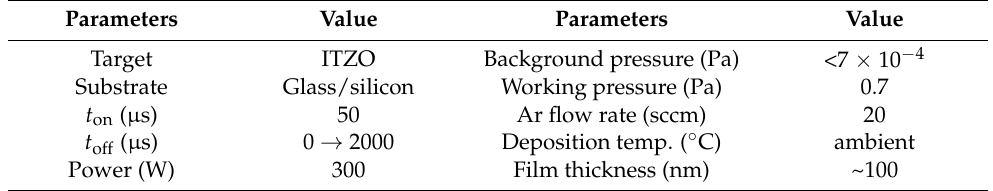
Table 1. Sputtering parameters maintained during deposition of ITZO thin